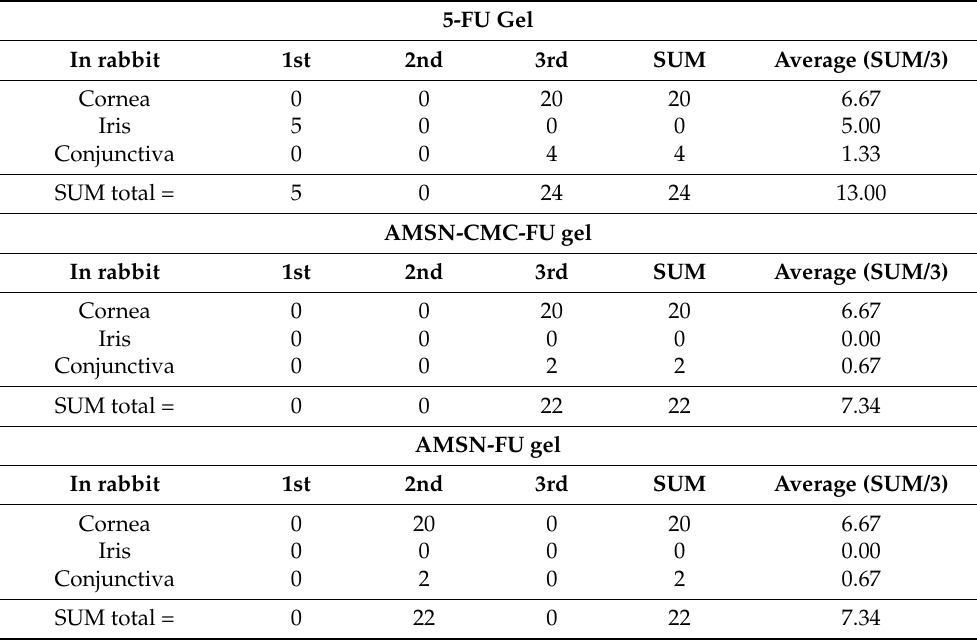
Table 5. Calculation of Maximum Mean Total Score (MMTS) by considering the obtained